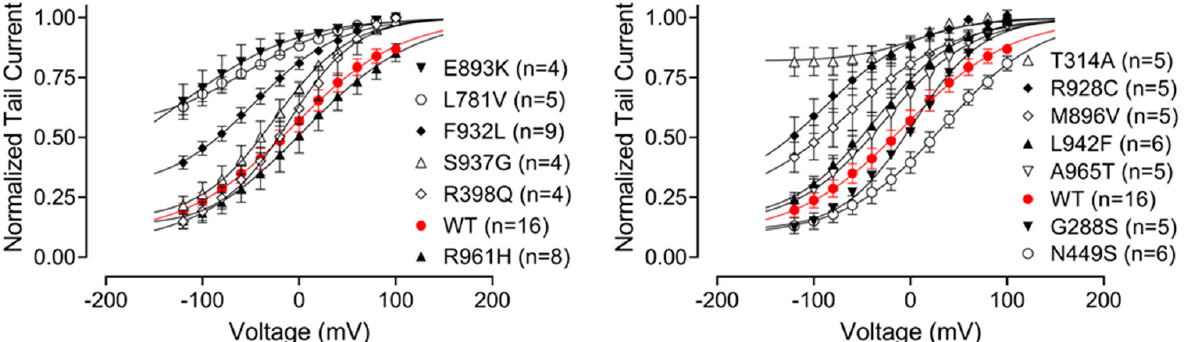
Figure 4. The effect of GoF mutations on the relative open probability of KCNT1 channels. Apparent P o curves of WT and mutant KCNT1 channels were obtained from tail currents normalised to the instantaneous tail current amplitude corresponding to a voltage step to 100 mV using recordings similar to those shown in Figure 3. Each data set was fitted with the Boltzmann equation (Section 4, Equation (1)).